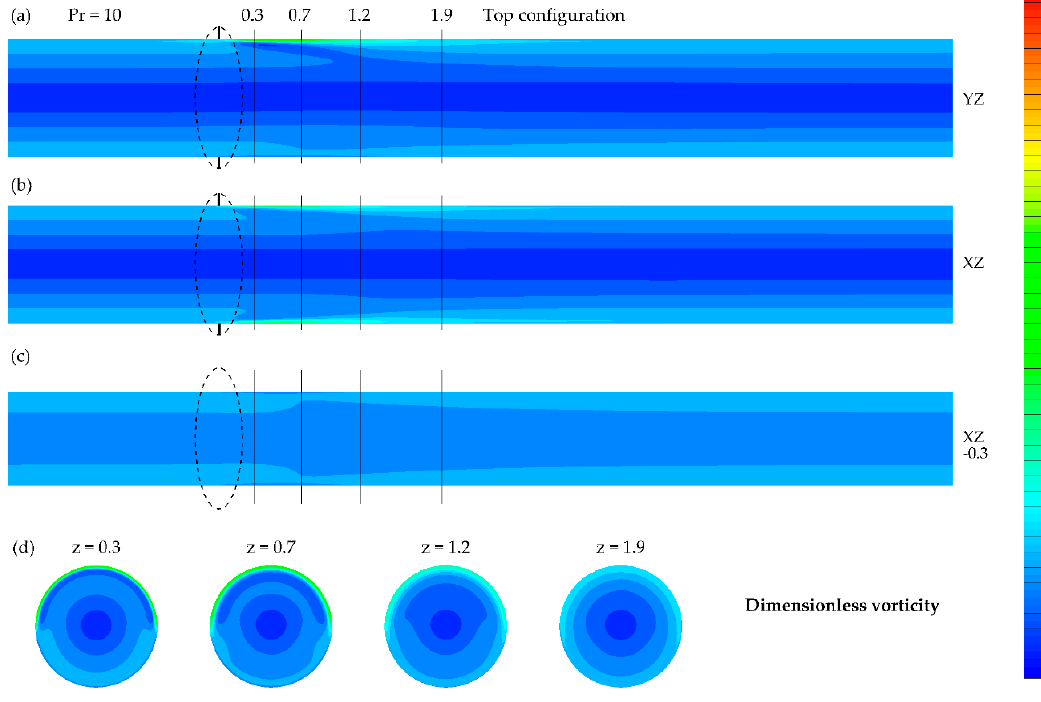
Figure 16. Dimensionless vorticity contours obtained for Pr = 10 and top configuration in the presence of the magnetic field at: ( a ) YZ plane, ( b ) XZ plane, ( c ) XZ plane ( y = − 0.3), ( d ) XY planes at given z .